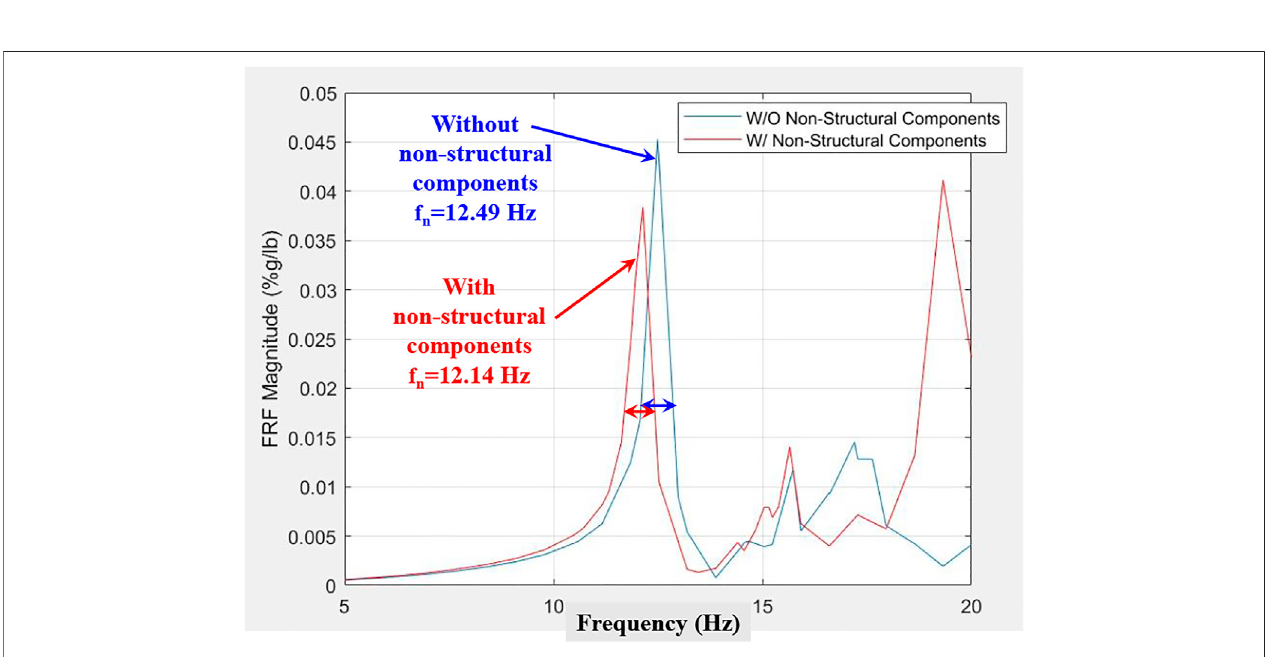
FIGURE 14 | Comparison of FE model FRFs: “ pre-installation of non-structural components ” vs. “ post-installation of non-structural components. ”